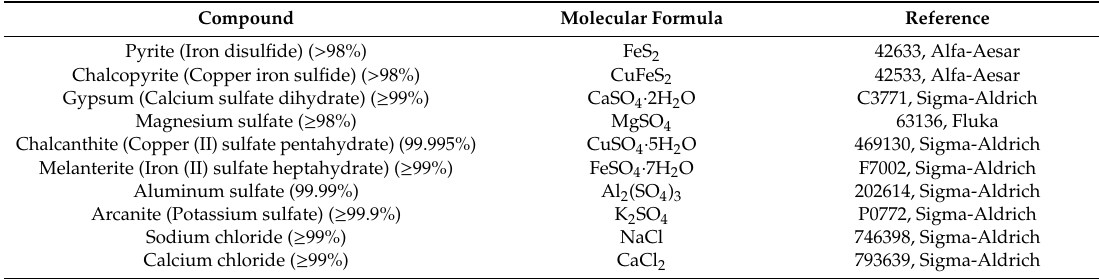
Table 1. Compounds studied with the evolved gas analysis (EGA)